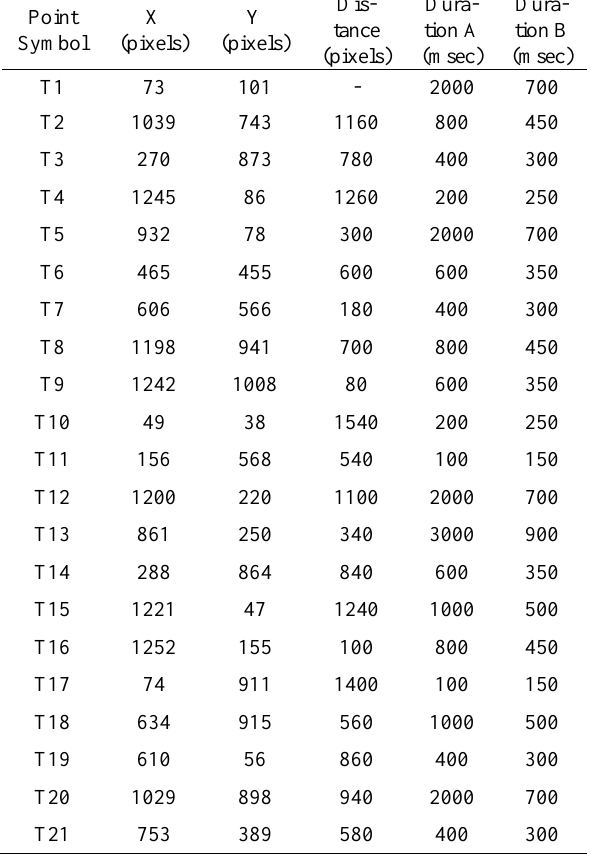
The locations coordinates (in pixels) of point map symbols as well as selected distances (in pixels) and durations (into two groups, in msec).